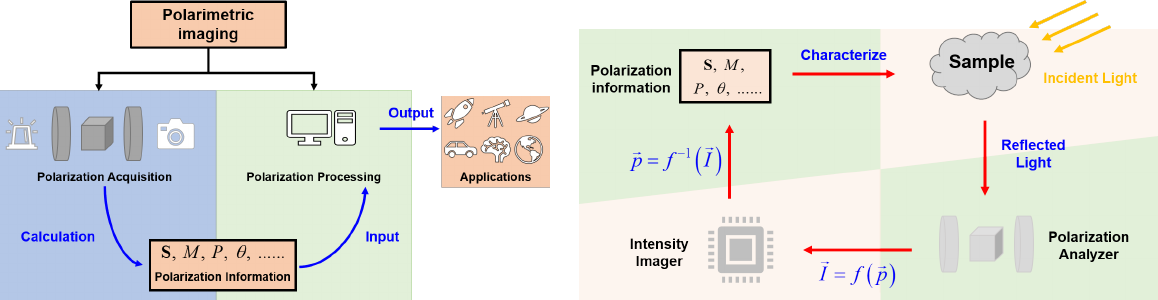
Figure 2. ( Left ) General steps of PI: Polarization parameters S -Stokes vector, M -Muller matrix, P -degree of polarization, and θ -angle of polarization. ( Right ) Schematic of Polarization acquisition: (cid:126) p denotes the polarization information of the sample/light-beam, (cid:126) I the multi-intensity captured by imagers and f the operator corresponding to the PI